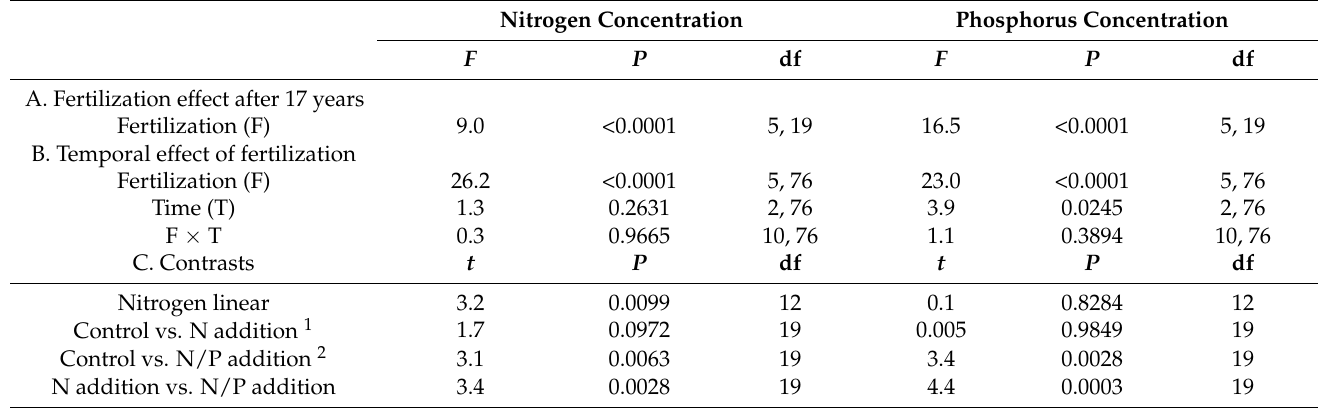
Table 6. Results of linear mixed models evaluating the effects of (A) fertilization after 17 years, and (B) fertilization, time after initiation of the experiment (2, 5 and 17 years) and their interaction on the N and P concentration of mosses in the tundra wetlands of Bylot Island, Nunavut. (C) A priori contrasts were also applied on fertilization effects after 17